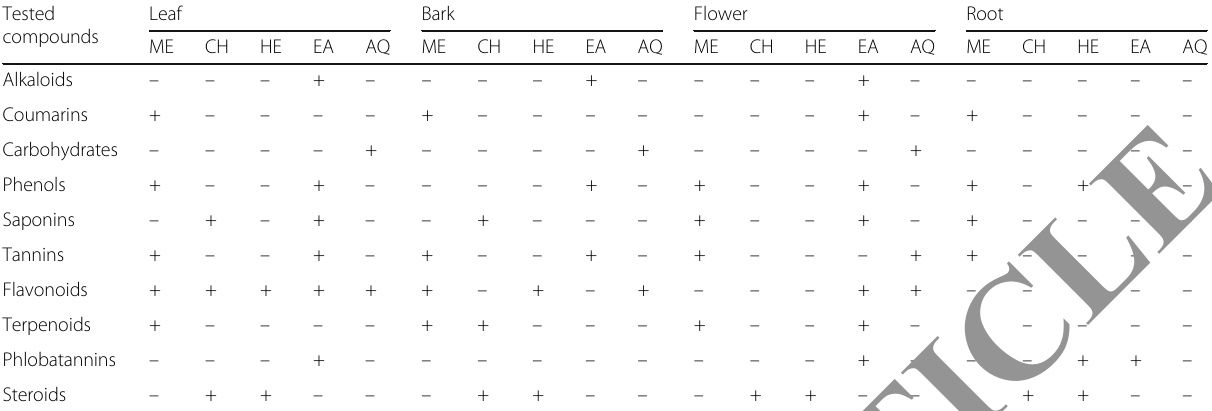
Table 2 Phytochemical constituents of Pongamia pinnata in different extracts of leaf, bark, flower and root Tested